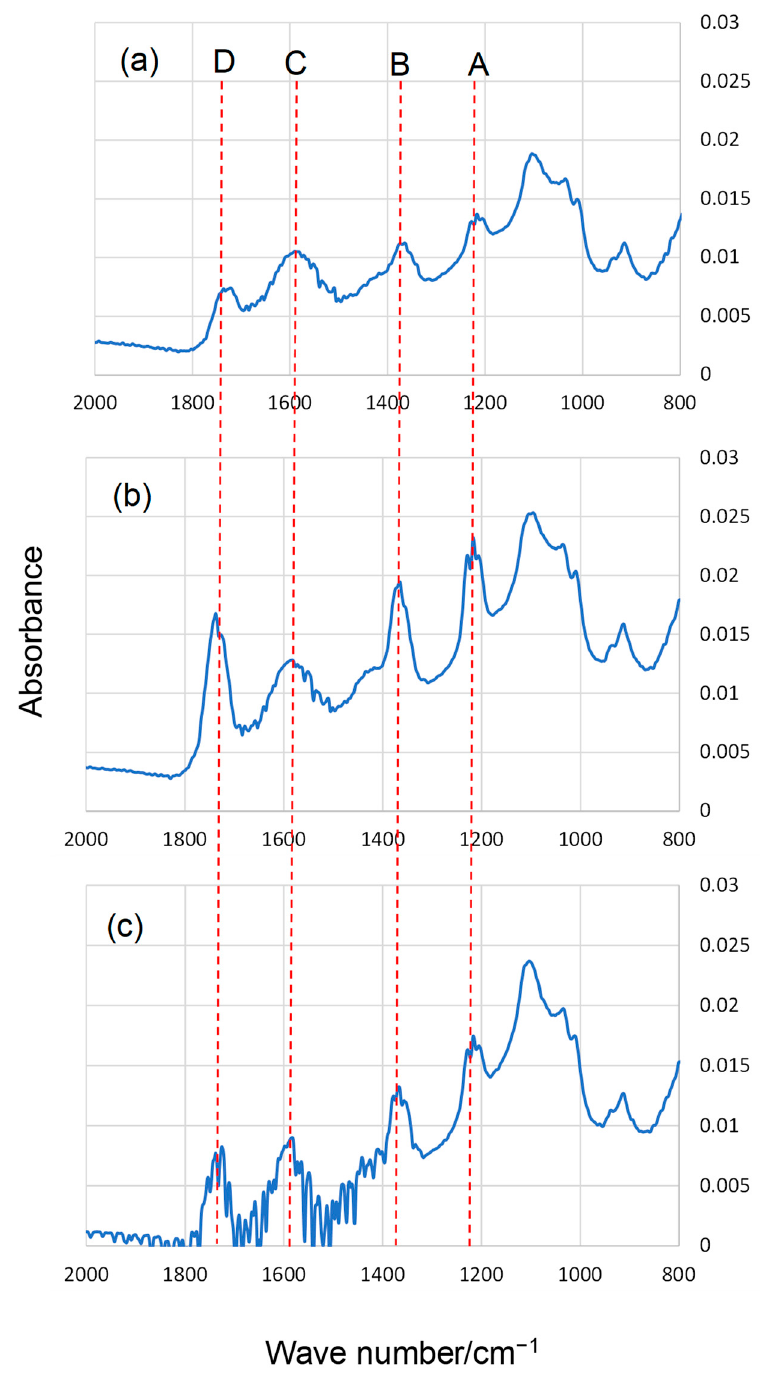
Figure 3. Typical FT-IR spectra of HA ( a ) before ozone exposure, ( b ) after 6 h ozone exposure, and ( c ) after 10 h ozone exposure (see text for detailed assignments of peaks